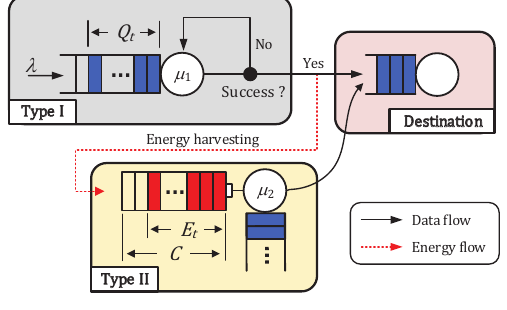
Figure 1. Original system